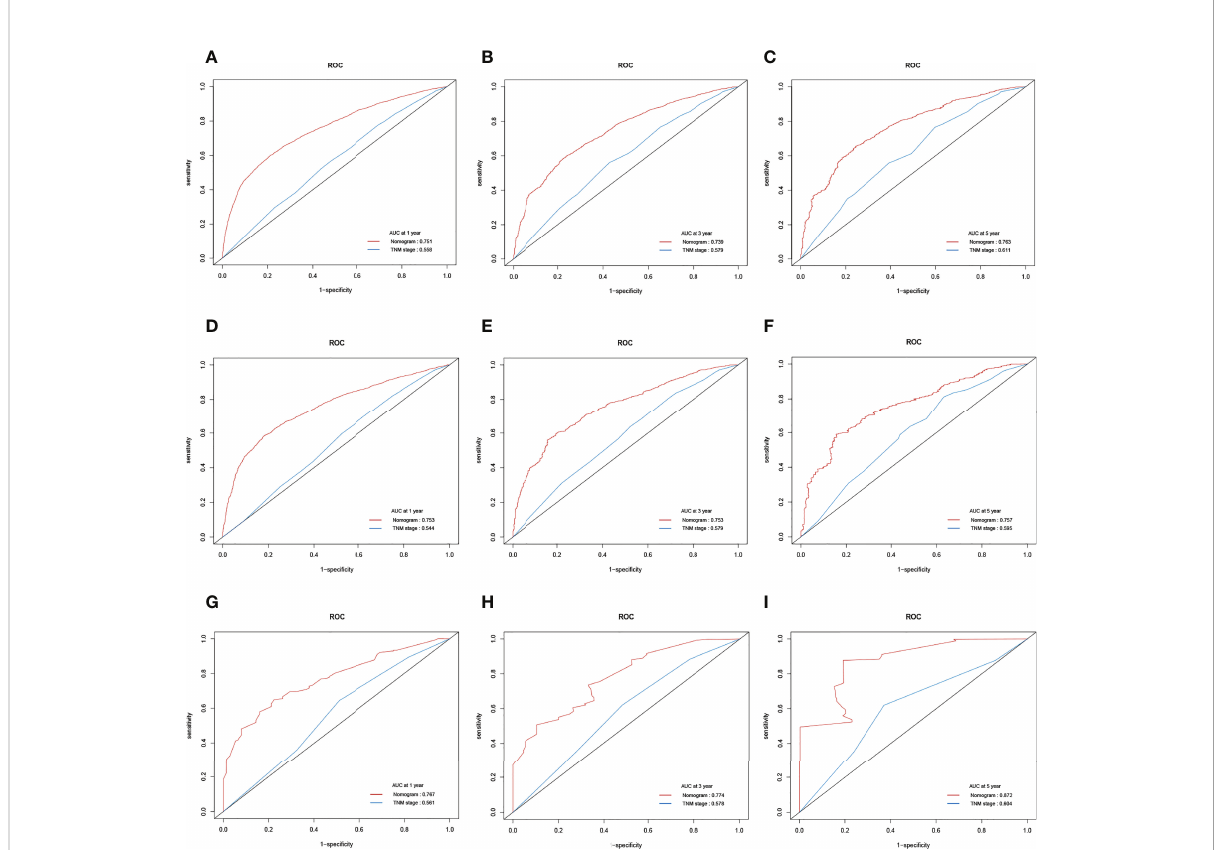
FIGURE 6 The receiver operating characteristic (ROC) curve of the TNM stage and the cancer-speci fi c survival (CSS) nomogram. (A – C) The area under the curve (AUC) values of ROC predicted 1-, 3-, and 5-year CSS rates of the nomogram and TNM stage in the training cohort. (D – F) AUC values of ROC predicted 1-, 3-, and 5-year CSS rates of the nomogram and TNM stage in the internal validation cohort. (G – I) AUC values of ROC predicted 1-, 3-, and 5-year CSS rates of the nomogram and TNM stage in the external validation